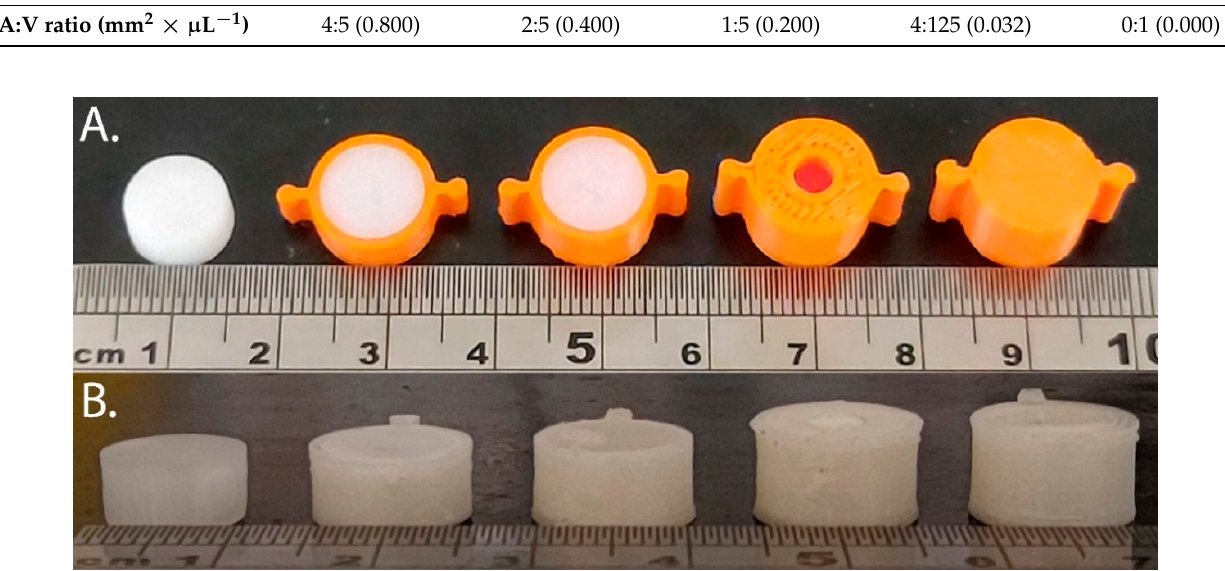
Figure 3. Tablet formats with decreasing exposed surface-area to-volume (SA:V) ratios from left to right generated from PLA (A) and PVOH (B) . Tablet formats from left to right: no-scaffold, dual-face, single-face, semi-open, closed.